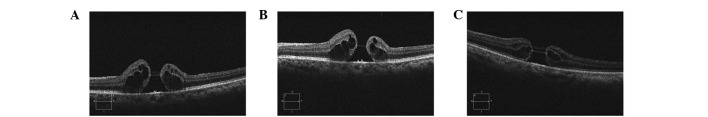
Serial OCT scans showing a patient with a stage III macular hole. (A) Preoperative OCT line scan demonstrates a full-thickness macular hole. (B) 2 DD of the ILM centered on the macular hole was peeled in the first PPV and the macular hole was not closed. (C) ILM peeling for the secondary surgery was enlarged to the vascular arcades of the posterior fundus and the macular hole was not closed. Cystic changes remained unresolved. OCT, optical coherence tomography; DD, disc diameter; ILM internal limiting membrane; PPV, pars plana vitrectomy.